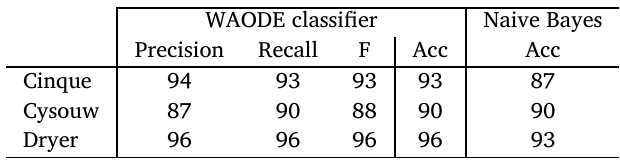
Percent of languages classified in the right frequency class, for a token-based four-way classification.